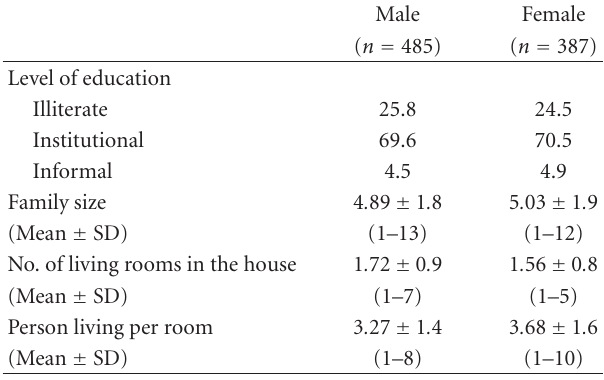
Figure 1: Age distribution ( N = 872).